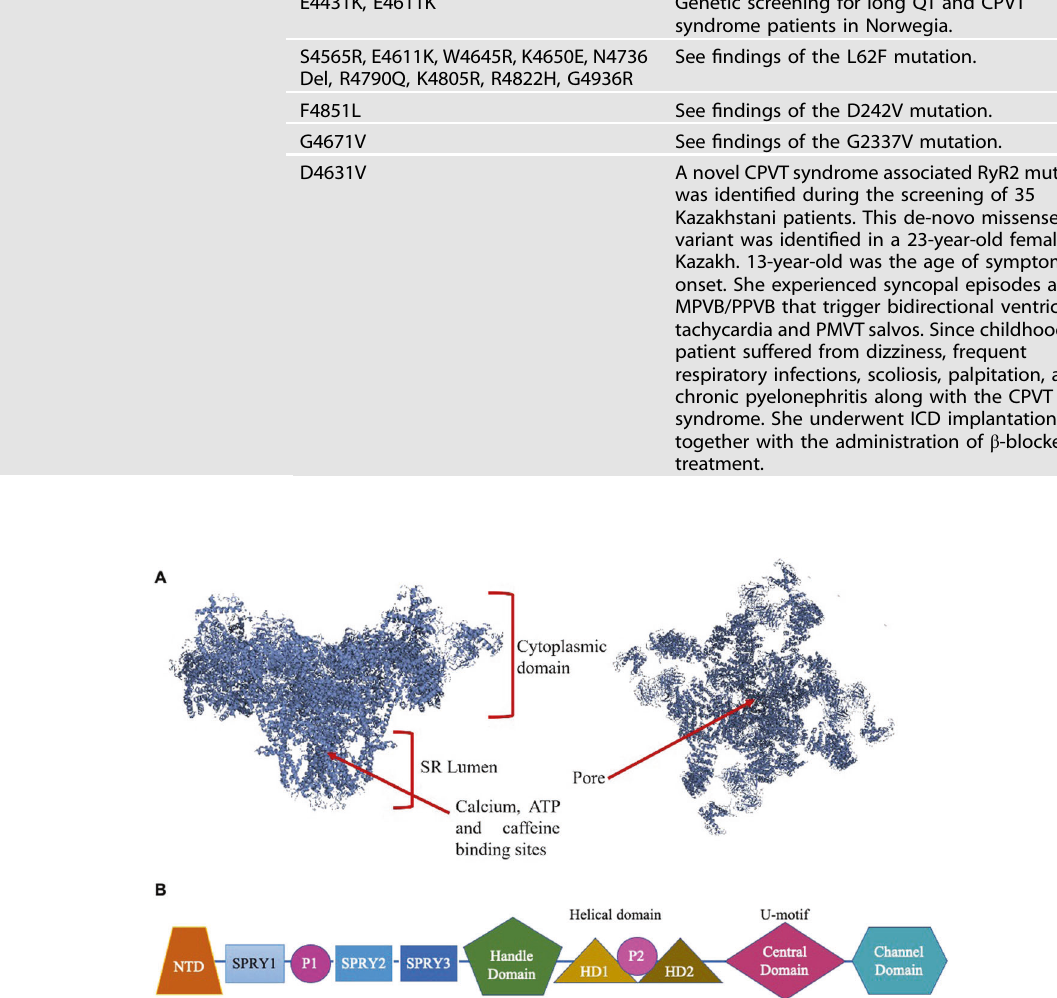
Fig. 1 Representative 3D structure of RyR2. A Illustration of the 3D structure of RyR2 viewed from the cytoplasmic side and adapted from Peng et al. [35]. B Domain organization of the RyR2. NTD N-terminal domain, SPRY splA kinase and RyR domain, P1/P2 RyR repeat domain rich in phosphorylation sites, HD1/HD2 Helical